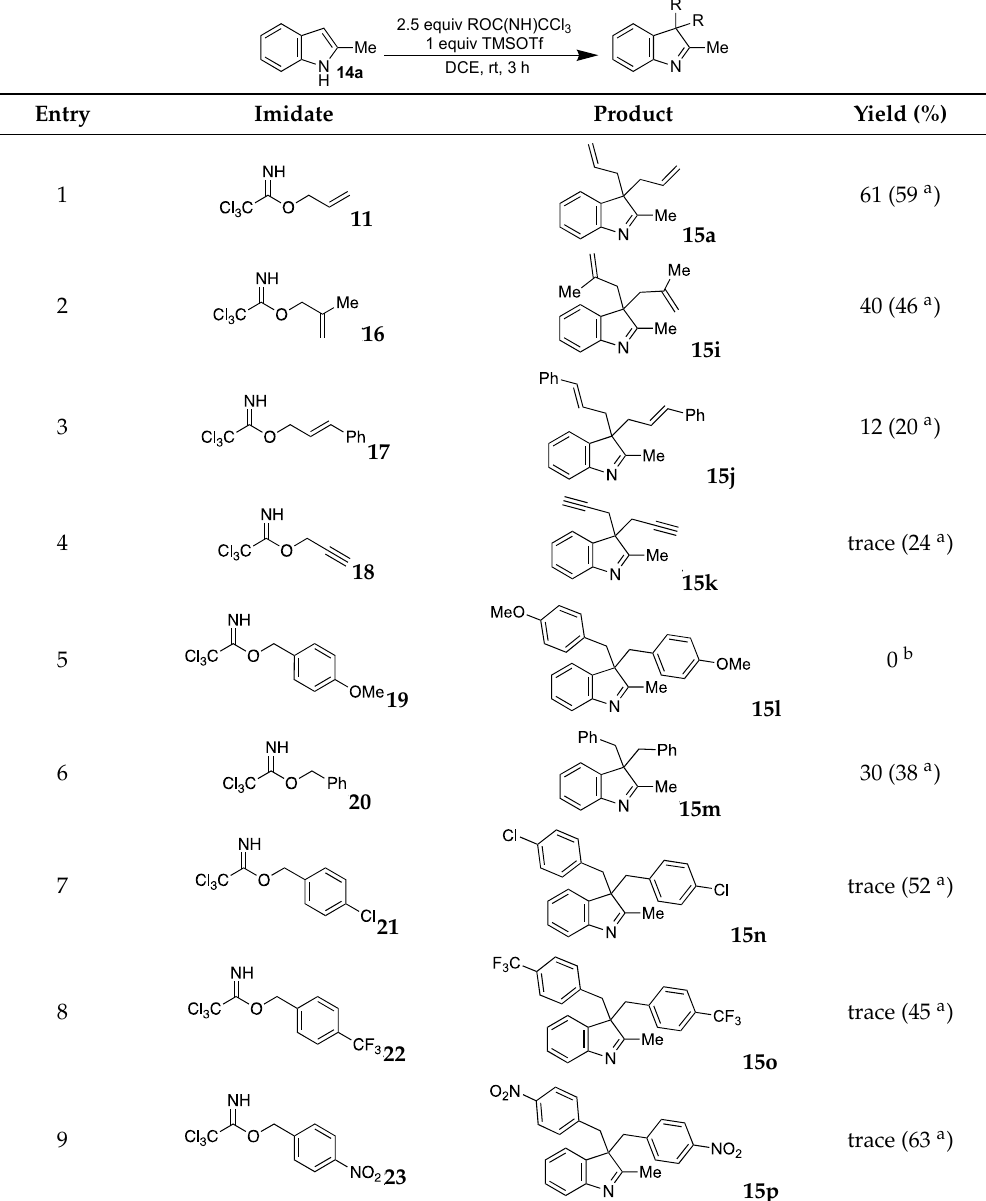
Molecules 2019 , 24 , x FOR PEER REVIEW Table 3. Direct C3-dialkylation of 2-methyl indole 14a with trichloroacetimidates. Table 3. Direct C3-dialkylation of 2-methyl indole 14a with trichloroacetimidates. Table 3. Direct C3-dialkylation of 2-methyl indole 14a with trichloroacetimidates. Table 3. Direct C3-dialkylation of 2-methyl indole 14a with trichloroacetimidates. Table 3. Direct C3-dialkylation of 2-methyl indole 14a with trichloroacetimidates. Table 3. Direct C3-dialkylation of 2-methyl indole 14a with trichloroacetimidates. Table 3. Direct C3-dialkylation of 2-methyl indole 14a with trichloroacetimidates. Table 3. Direct C3-dialkylation of 2-methyl indole 14a with trichloroacetimidates. Table 3. Direct C3-dialkylation of 2-methyl indole 14a with trichloroacetimidates. Table 3. Direct C3-dialkylation of 2-methyl indole 14a with trichloroacetimidates. Table 3. Direct C3-dialkylation of 2-methyl indole 14a with trichloroacetimidates. Table 3. Direct C3-dialkylation of 2-methyl indole 14a with trichloroacetimidates. Table 3. Direct C3-dialkylation of 2-methyl indole 14a with trichloroacetimidates. Table 3. Direct C3-dialkylation of 2-methyl indole 14a with trichloroacetimidates. Table 3. Direct C3-dialkylation of 2-methyl indole 14a with trichloroacetimidates. Table 3. Direct C3-dialkylation of 2-methyl indole 14a with trichloroacetimidates. Table 3. Direct C3-dialkylation of 2-methyl indole 14a with trichloroacetimidates. Table 3. Direct C3-dialkylation of 2-methyl indole 14a with trichloroacetimidates. Table 3. Direct C3-dialkylation of 2-methyl indole 14a with trichloroacetimidates. Table 3. Direct C3-dialkylation of 2-methyl indole 14a with